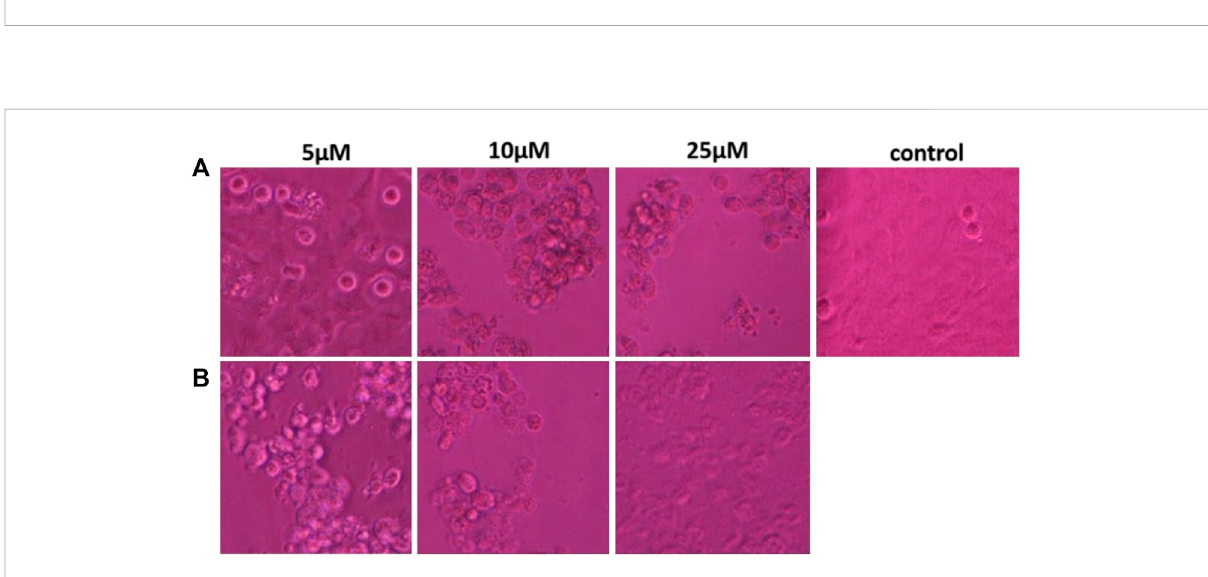
FIGURE 4 (A) Hemolytic activity of ZRTs nanoparticles: The extent of damage caused to red blood cells by the ZRT was measured as percent lysis of total erythrocytes used in the individual sample. (B) : In vitro cytotoxicity assay: Dose – response effects of ZRTs nanoparticles on cytotoxicity against Vero